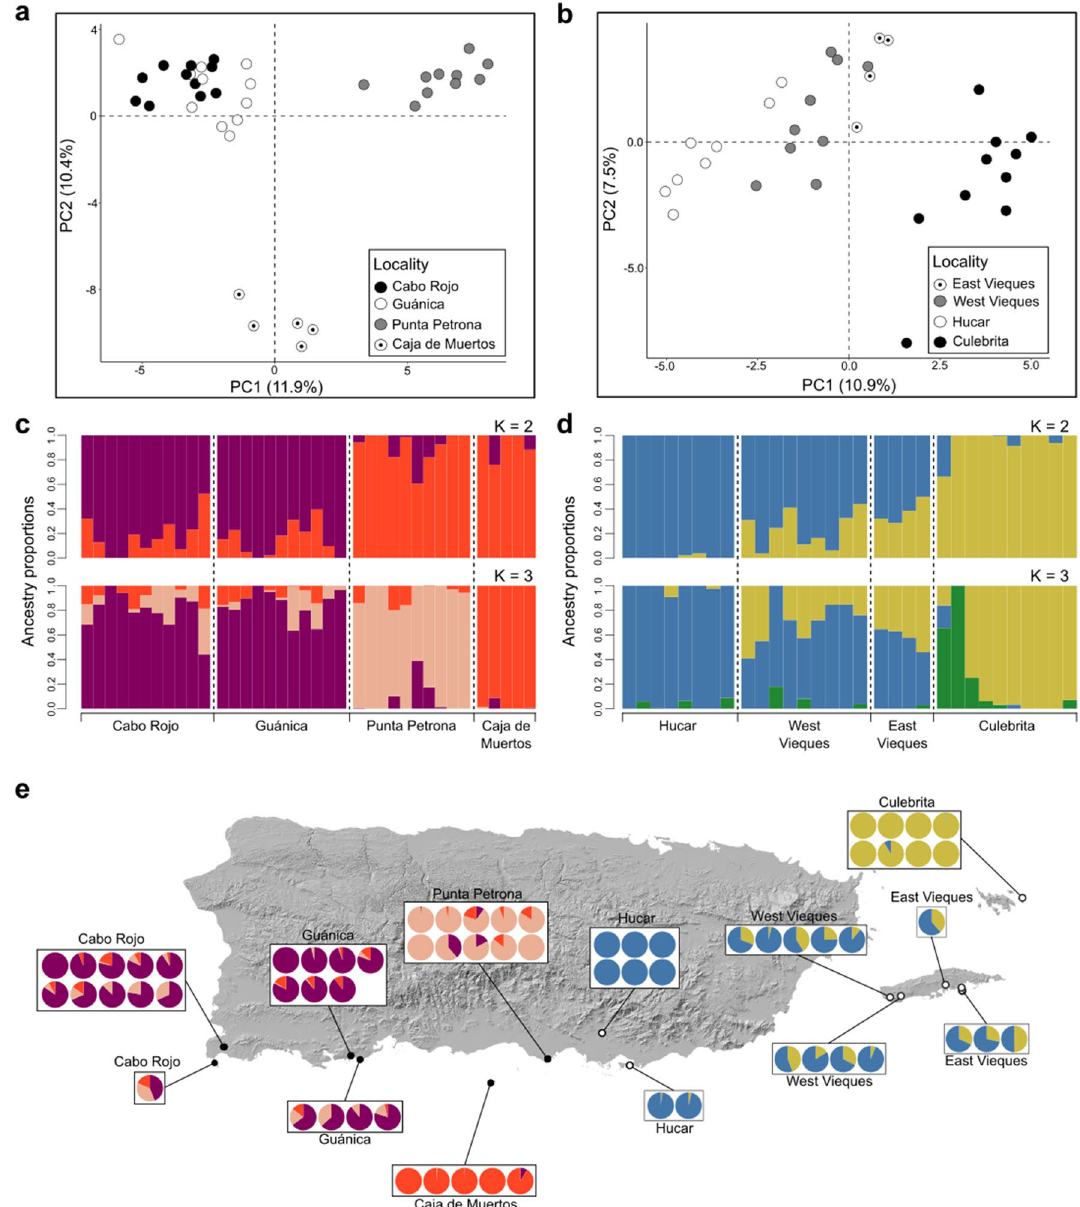
Figure 3. Population genetic structure of both Hypogeococcus species invading Puerto Rico. Visual representation of population genetic structure and individual ancestry coefficient of Hyp-C and Hyp-AP, using PCA ( a, b ) and sNMF ( c–e ), respectively. PCA shows the grouping of three subpopulations belonging to the Puerto Rico mealybug cactus pest ( a ), and two main subpopulations representing Hyp-AP ( b ). Vertical bars in panels c and d represent individuals along with membership probability of each individual to the corresponding subpopulations in Hyp-C and Hyp-AP, respectively. Panel e shows ancestry coefficients for each individual of both putative species plotted on a map of Puerto